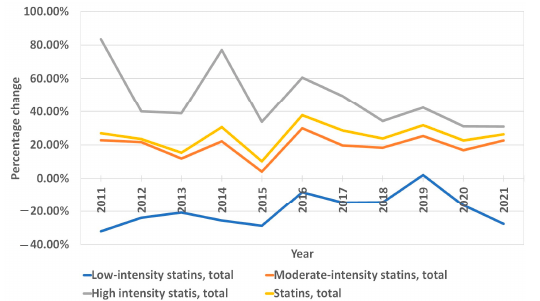
Figure 3. Annual percentage change in statin sales according to therapy intensity.